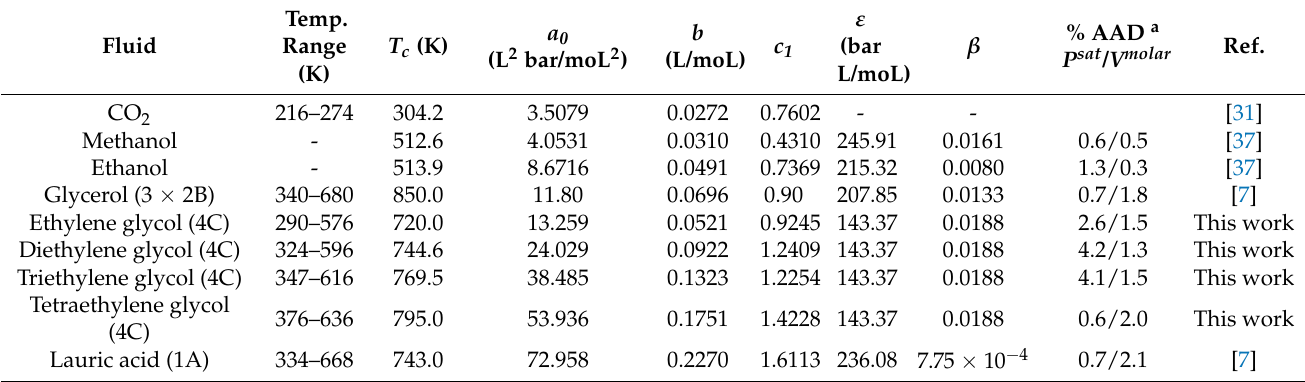
Table 1. Pure fluid parameters (the association scheme is mentioned in